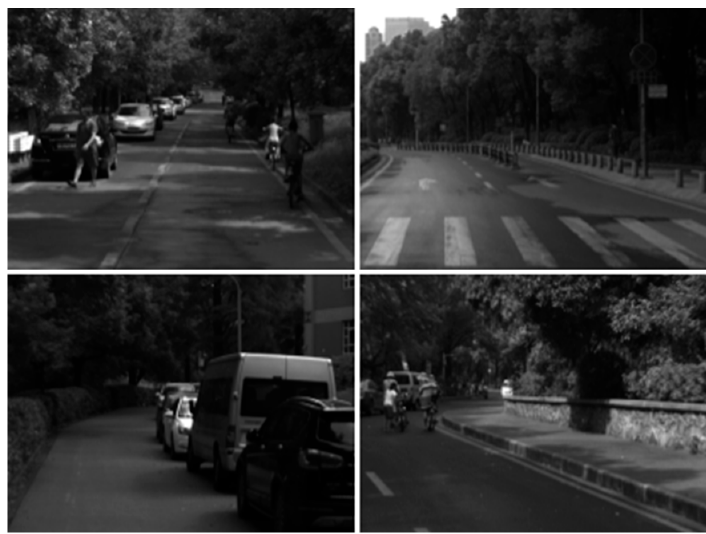
Figure 3. Typical scenarios in tree-lined roads.